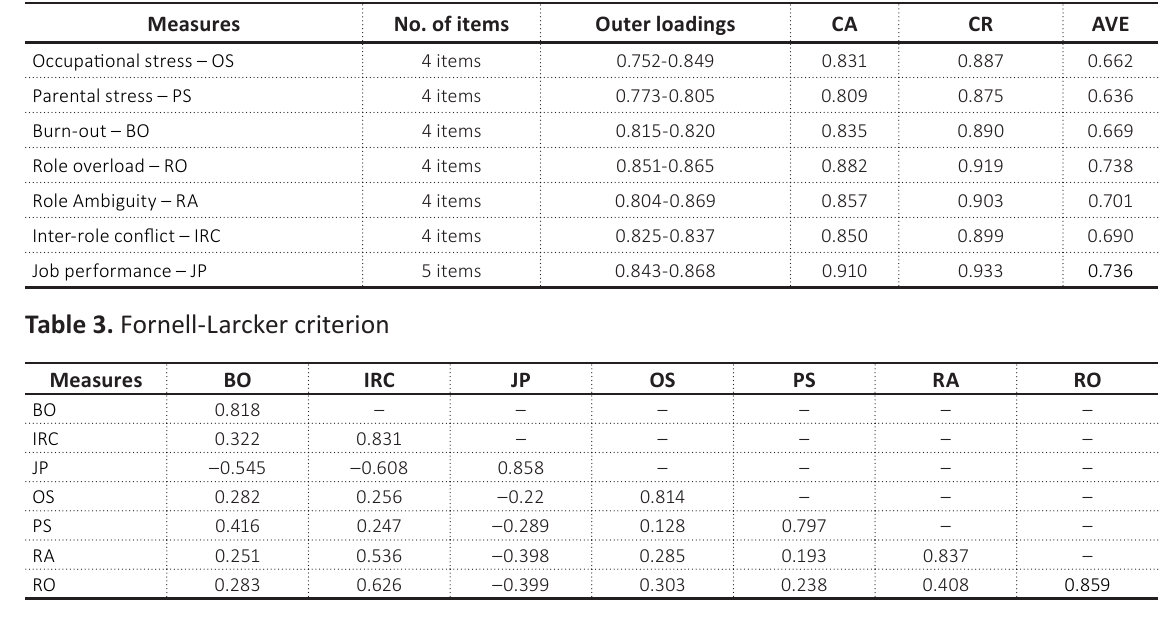
Table 2. Analysis of the internal consistency reliability and the convergent validity